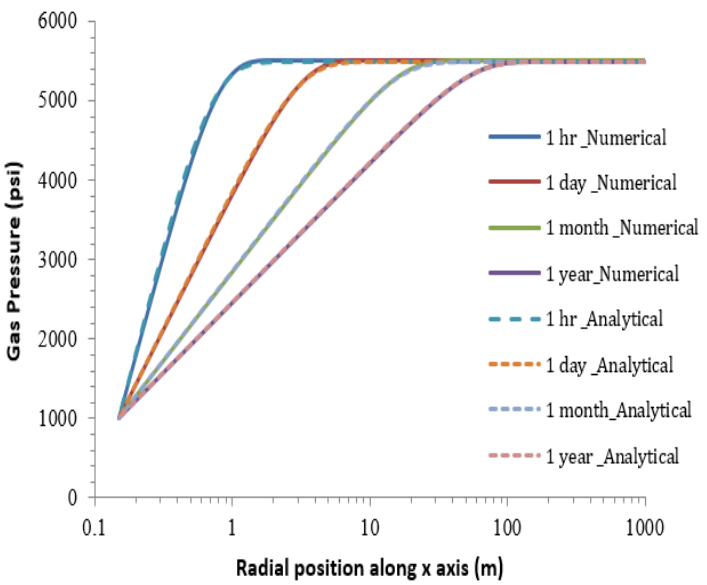
Figure 4. The comparison between analytical and numerical solution of shale gas pressure for Pi = 5500 psi, Pwf = 1000 psi and k-0.01 md.